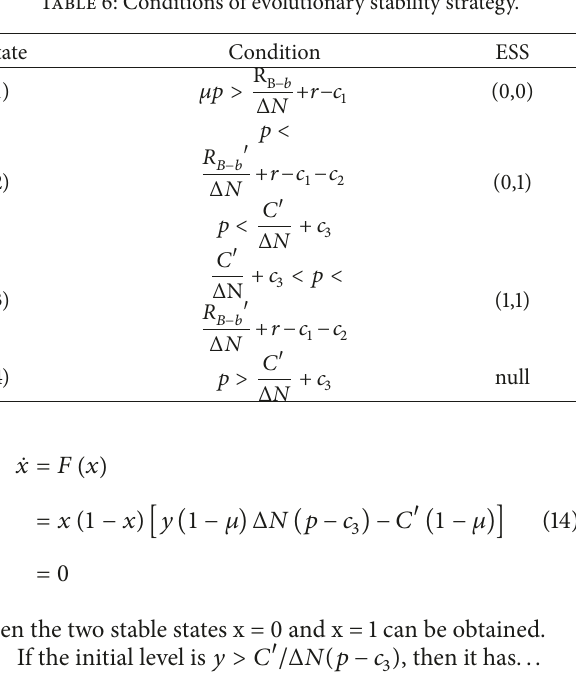
Table 6: Conditions of evolutionary stability